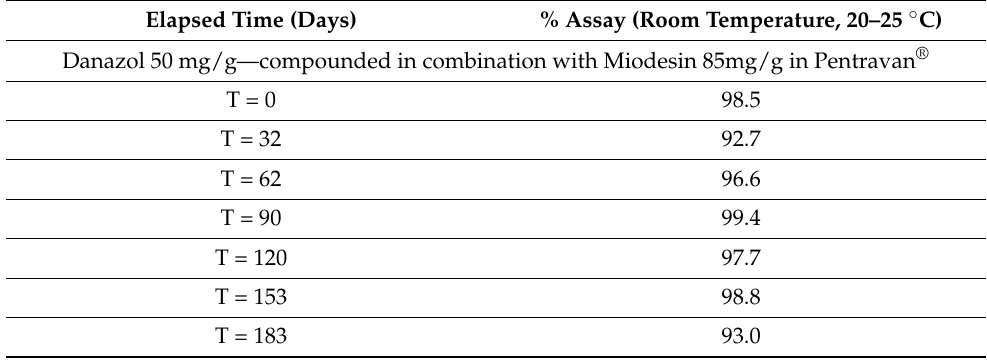
Table 3. Stability of the active pharmaceutical ingredients in Pentravan ® or Pentravan ®